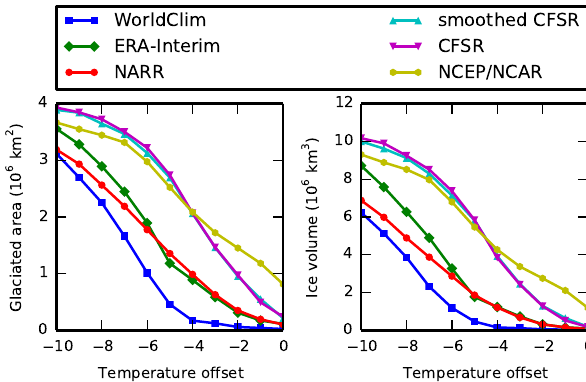
Figure 5. Total glaciated area and ice volume after 10kyr as a function of temperature offset for each climate forcing used.